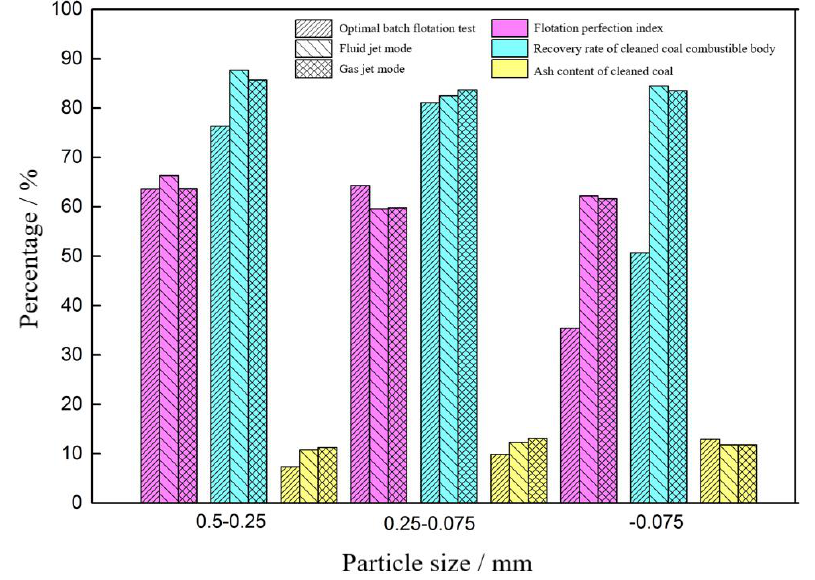
Figure 13. Results comparison of coal slime mixing test and batch flotation test.